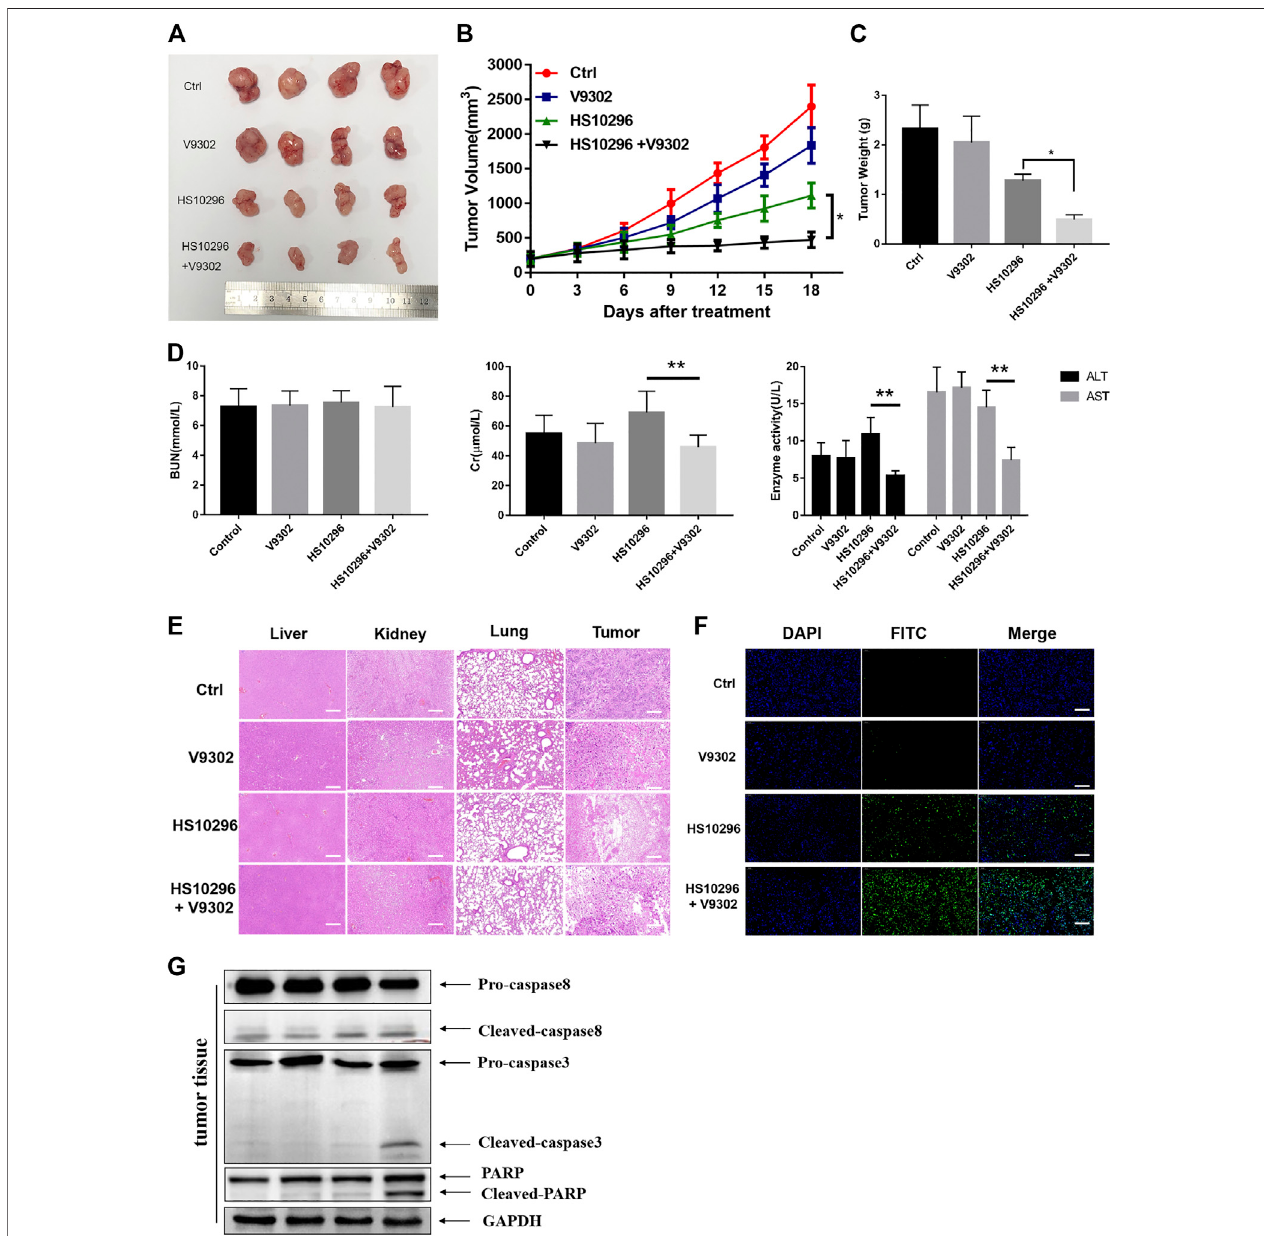
FIGURE 5 | V9302 enhanced the antitumor effect of Almonertinib in vivo . (A) Representative tumors from each treatment group. (B) Tumor weight of the mice. (C) Tumor volume of the mice. (D) Evaluation of toxicity in vivo in nude mice. AST, ALT, BUN and Cr of serum were measured by assay kits, respectively. (E) H&E-stained sectionsofthetumor,liver,lungandkidneyfromthemiceaftertreatment. (F) TUNELwasusedtodetectapoptosisintumortissues. (G) Proteinexpressionofcaspase8, caspase3 and PARP were detected by WB in tumor tissues. Signi fi cance: * p < 0.05, ** p < 0.01, *** p <